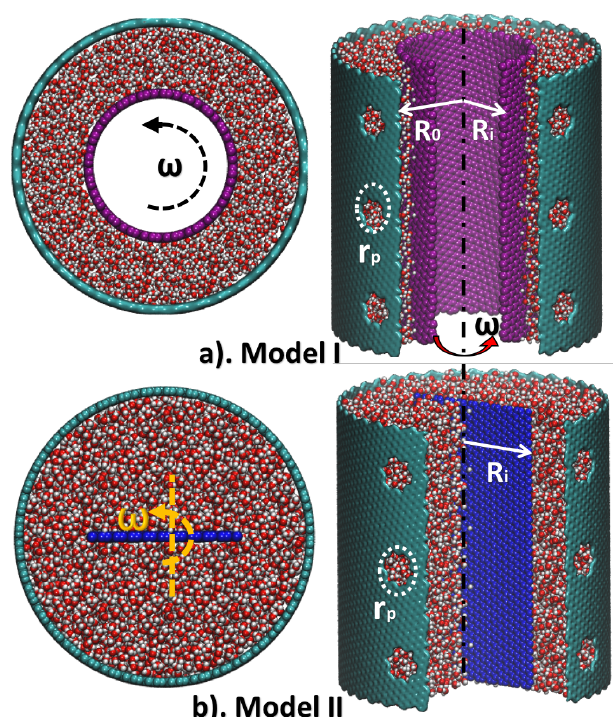
Figure 2. Molecular structures of two types of models for MD calculations. ( a ) The top and bisection view of Model I, with light-blue tube represents nanoporous membrane and pink tube represents rotator. ( b ) The top and bisection view of Model II, with light-blue tube represents nanoporous membrane and dark-blue tube represents